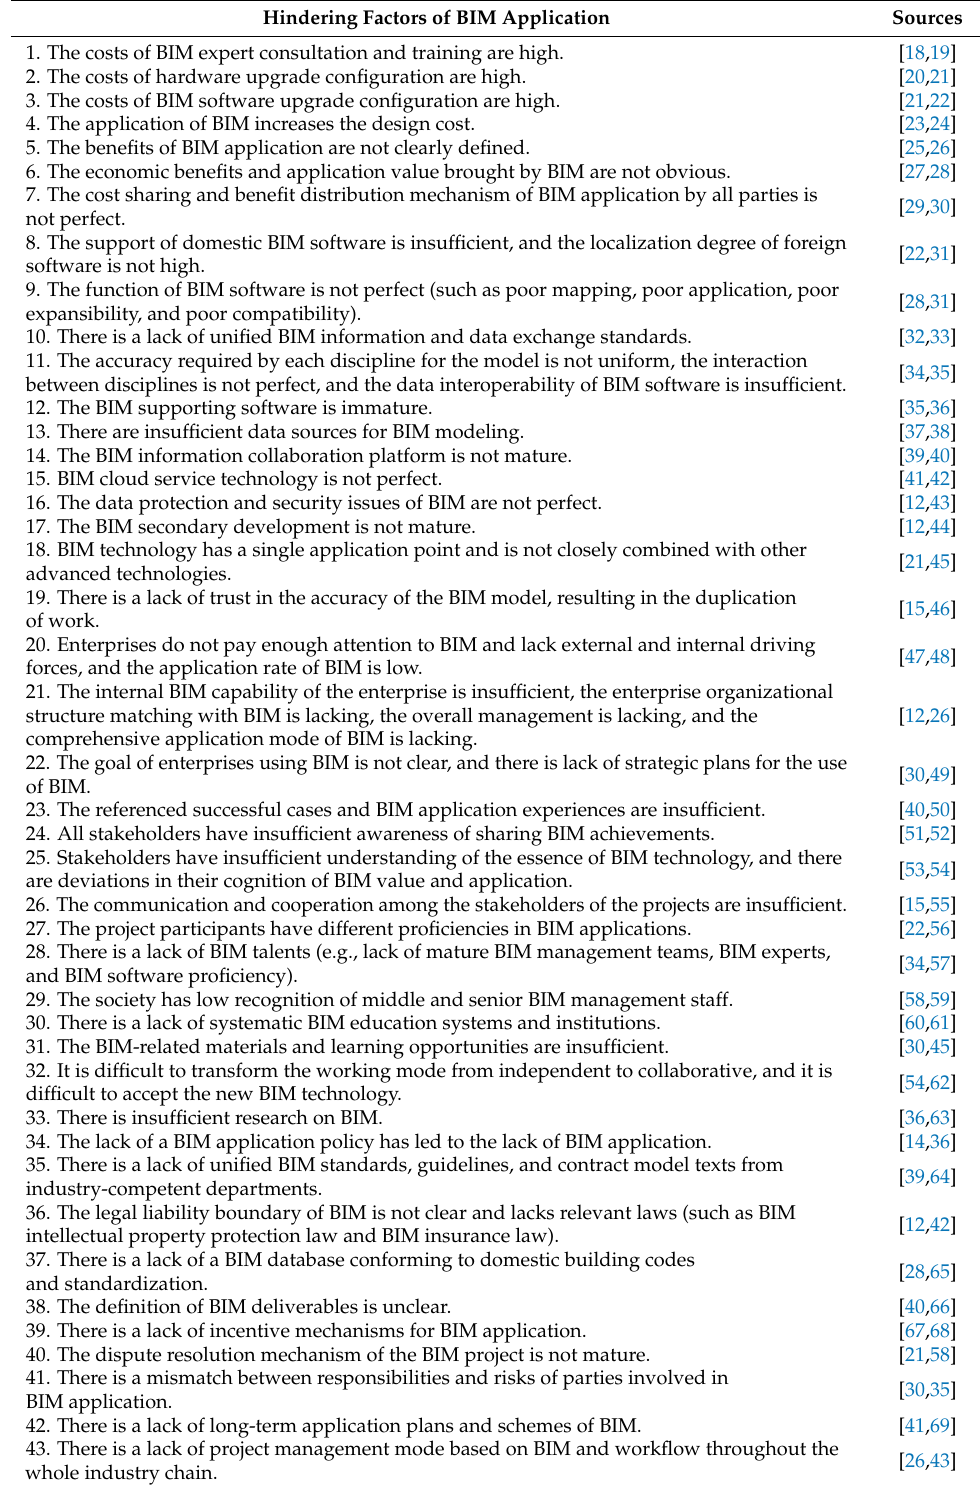
Table 1. List of hindering factors of BIM